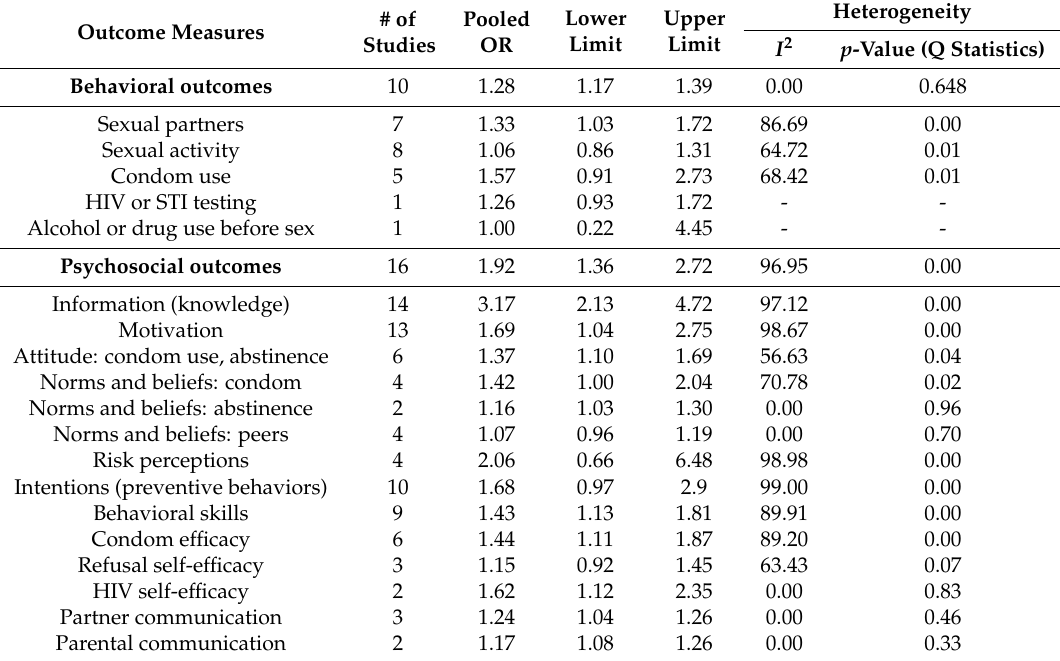
Figure 2. Forest plots. Table 3. Summary table for pooled effect sizes of outcome measures.